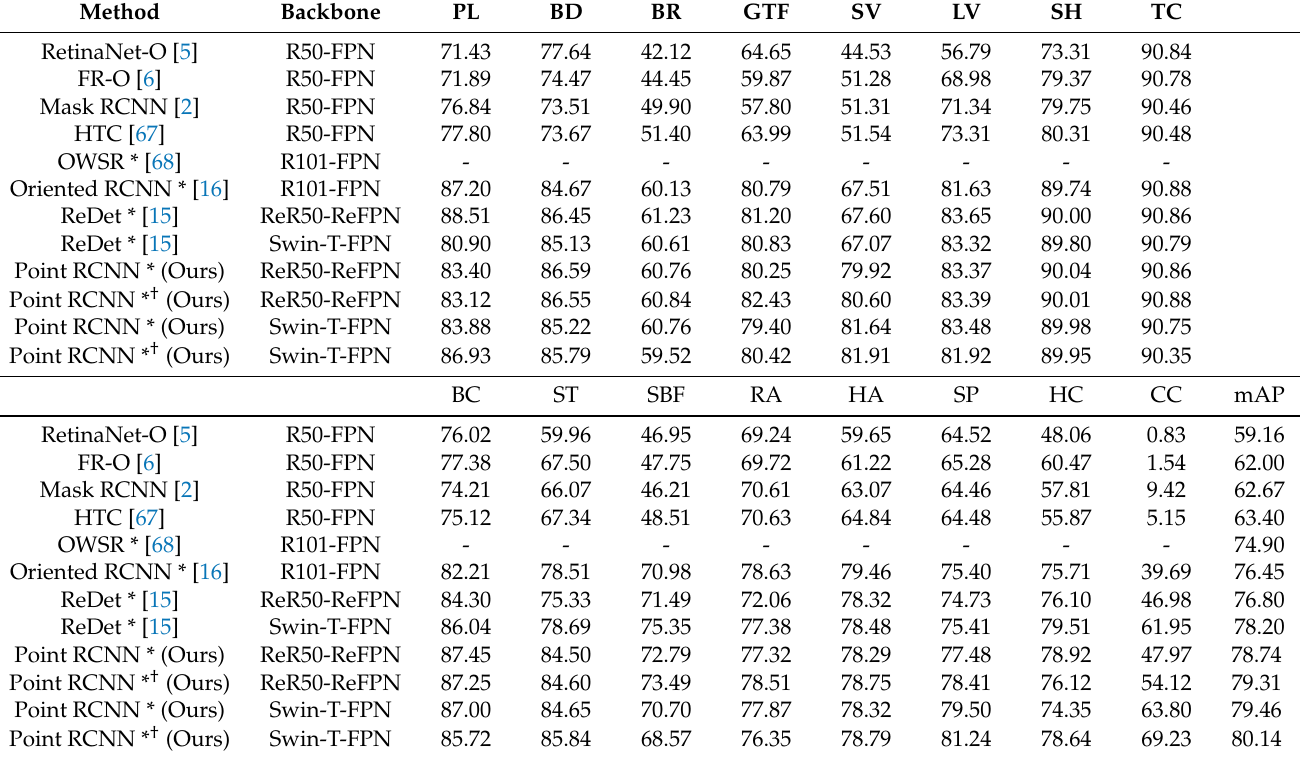
Table 3. Performance comparisons on DOTA-v1.5 test set (AP (%) for each category and overall mAP (%)). * denotes multi-scale training and testing, * † denotes the results of using balanced dataset strategy. Note that the results of Faster RCNN OBB (FR-O) [6], RetinaNet OBB (RetinaNet-O) [5], Mask RCNN [2] and Hybrid Task Cascade (HTC) [67] are excerpted from ReDet [15]. The results of Oriented RCNN* and ReDet* with Swin-T-FPN backbone are our re-implementations based on their released official code. “R50” denotes ResNet-50, “R101” denotes ResNet-101, “ReR50” denotes ReResNet-50, “Swin-T” denotes Swin Transformer